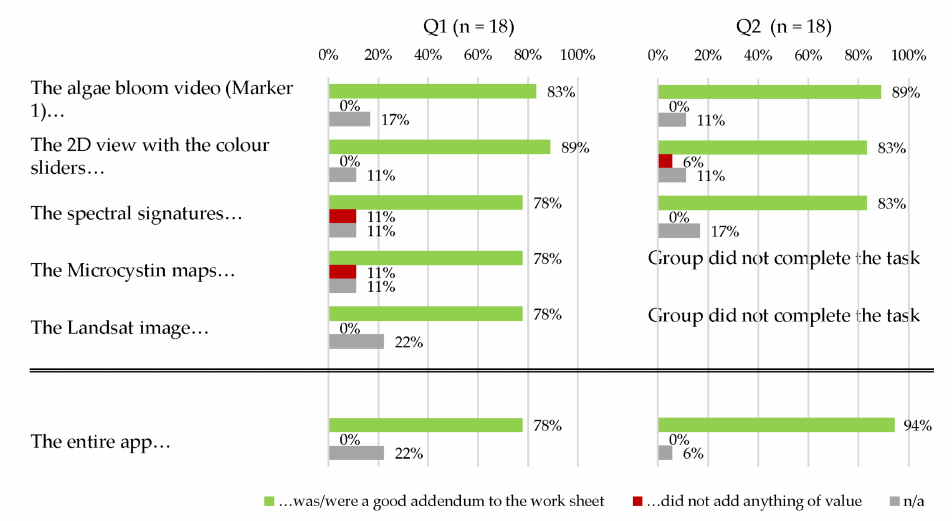
Figure 16. Subjective answers regarding the students’ opinion of the app.